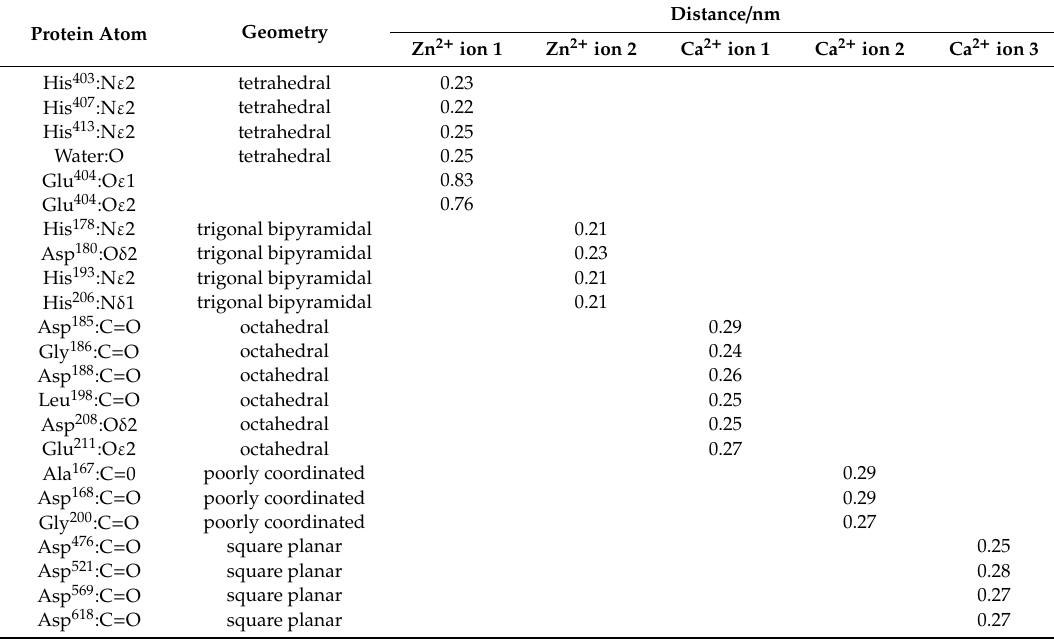
Table 1. Distances between ions and the interacting matrix metaloproteinase-2 (MMP-2) residue atoms and associated binding geometry identified from the 1CK7 X-ray crystal structure. Binding geometries and distances were determined using CheckMyMetal a,b,c